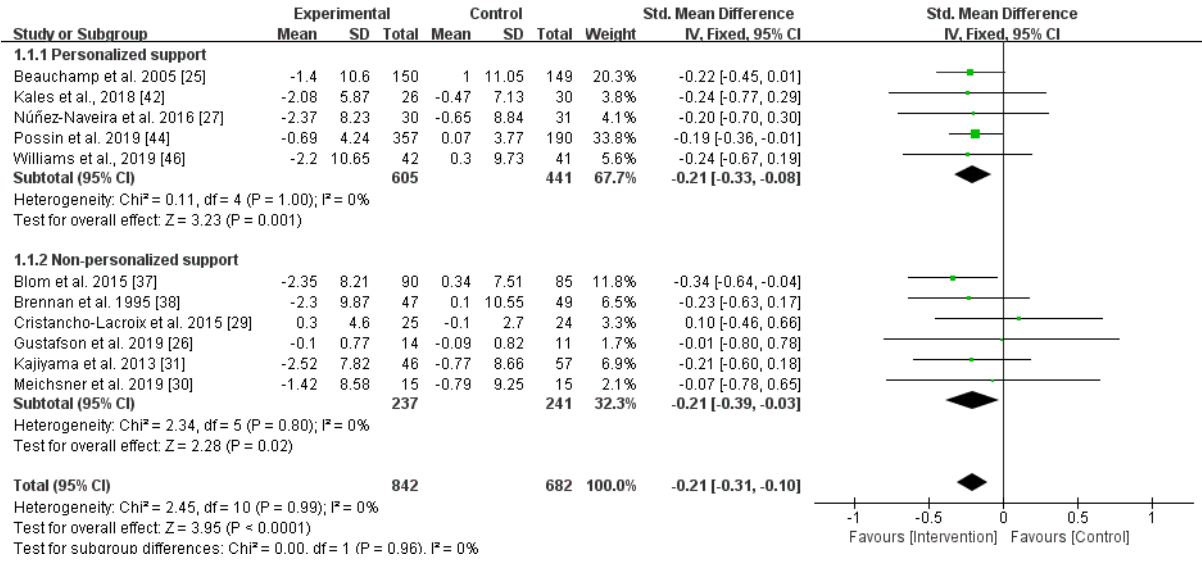
Figure 3. The effect of internet-based supportive interventions on depressive